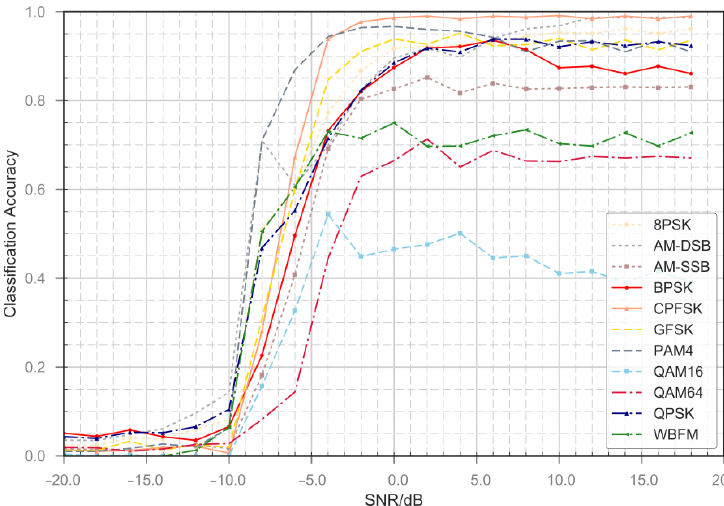
Figure 6. Correct recognition percentages versus SNR for all types of modulation signals.